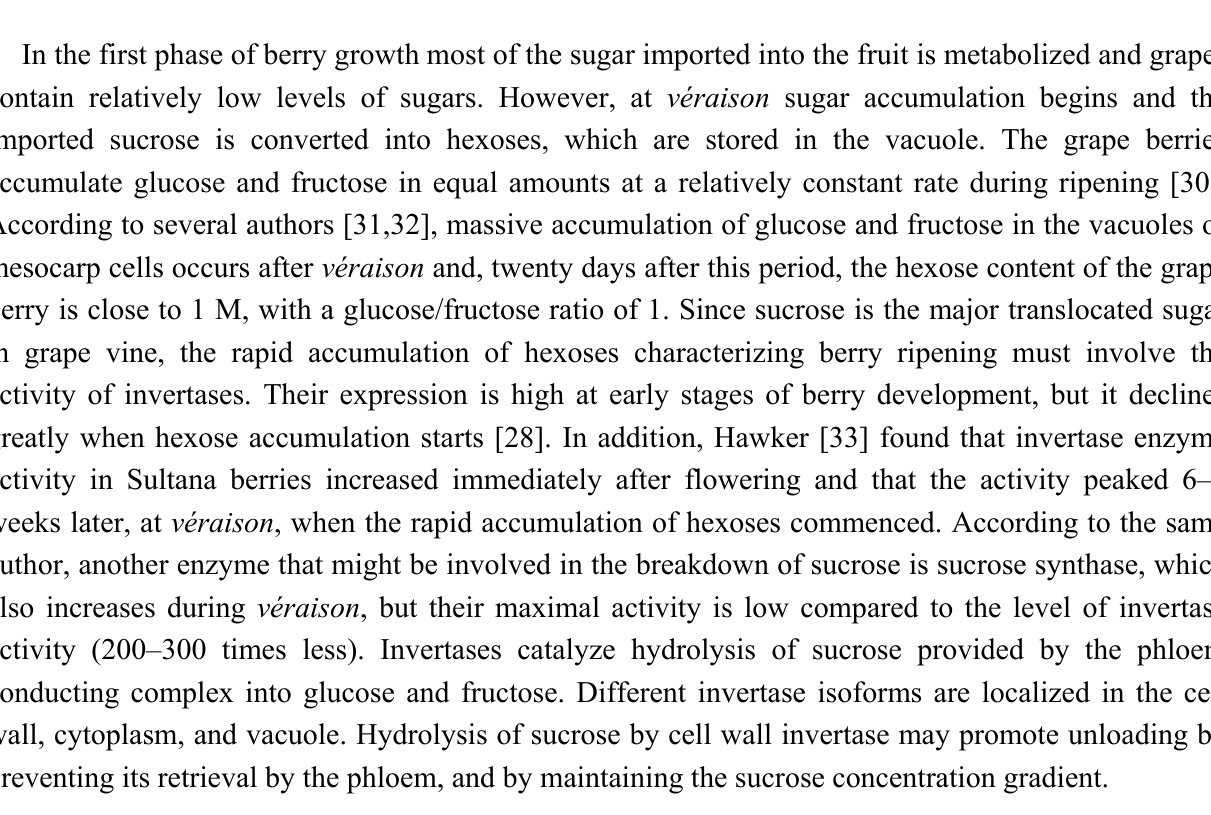
Figure 1. Schematic representation of grape berry development, sugar uptake, and metabolism during grape maturation. The curve indicates changes in berry size and two possible pathways are indicated for sugar uptake and metabolism. Legend: (-----) berry changes size. P 1 and V 1 — Hexose transporters ; P 2 and V 2 — Sucrose